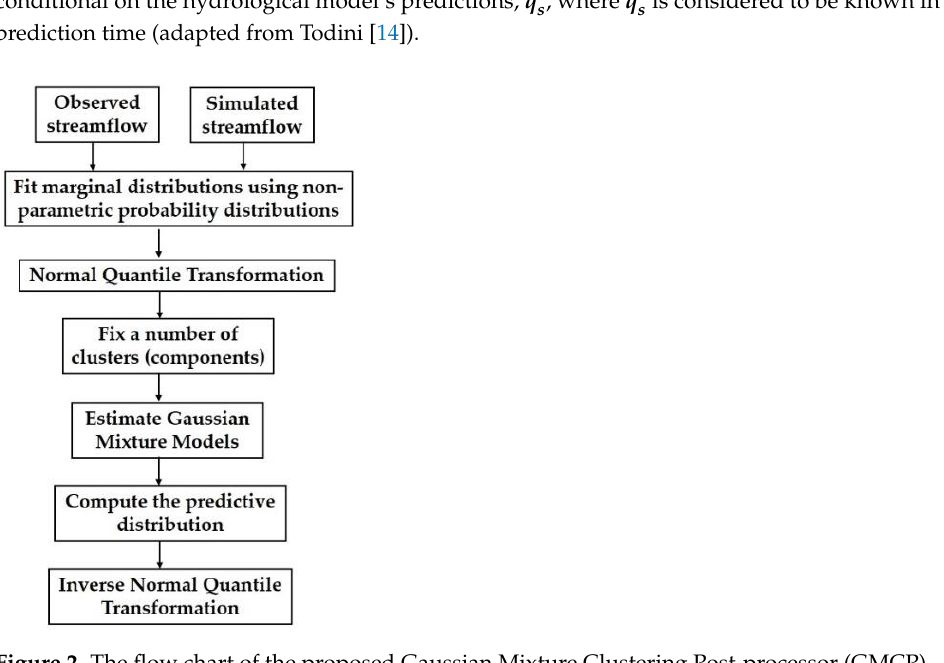
that is o , where q is considered to be known in the s s